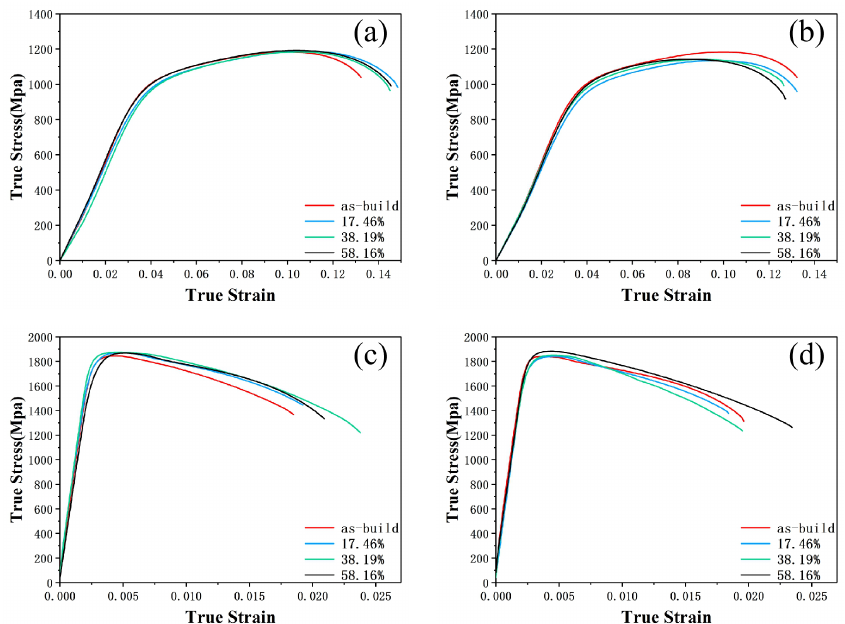
Figure 11. Tensile stress–strain curves of C250: ( a ) After deformation, CD; ( b ) After deformation, PD; ( c ) After heat treatment, CD; ( d ) After heat treatment, PD.